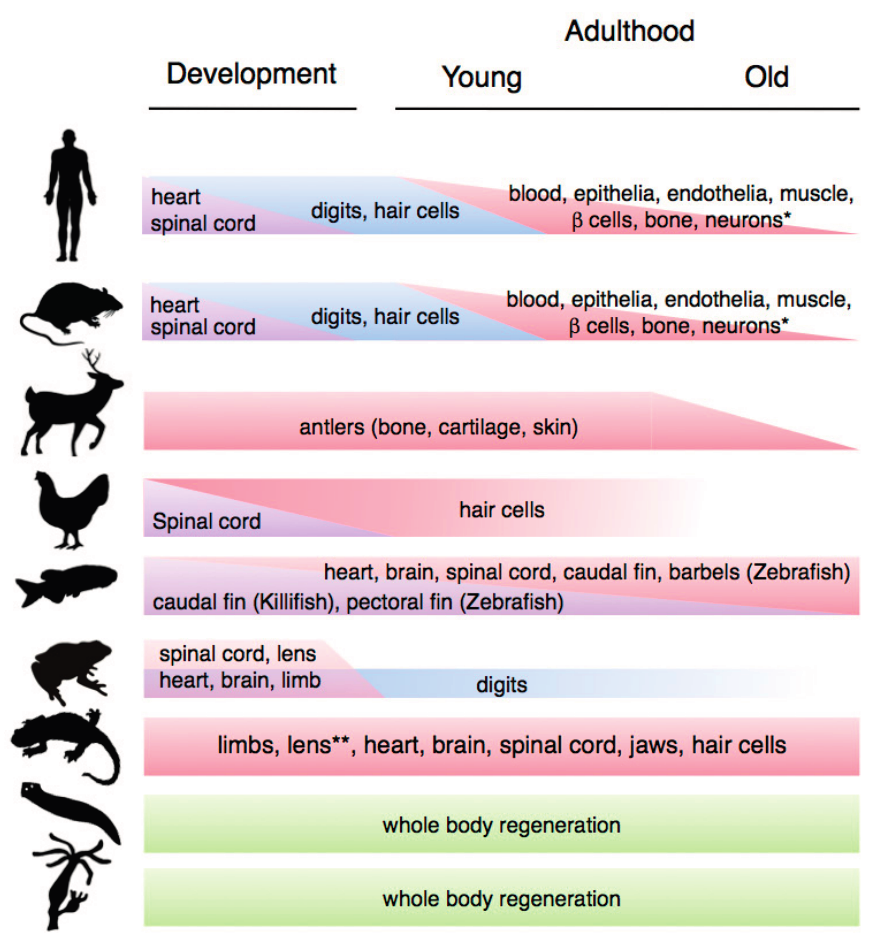
Figure 1. Variation in regenerative capacity through phylogeny, ontogeny and